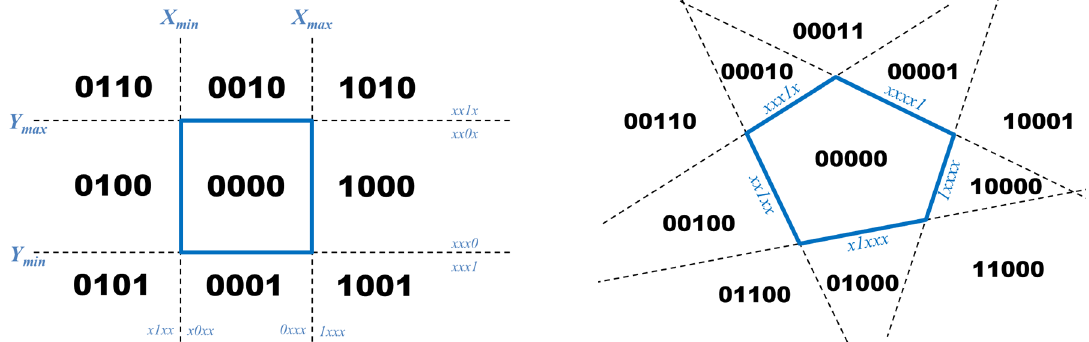
Figure 11. Bitmasks of the nine areas defined by the framing lines ( left ), extended approach to convex non-rectangular area with only some of the masks shown ( right